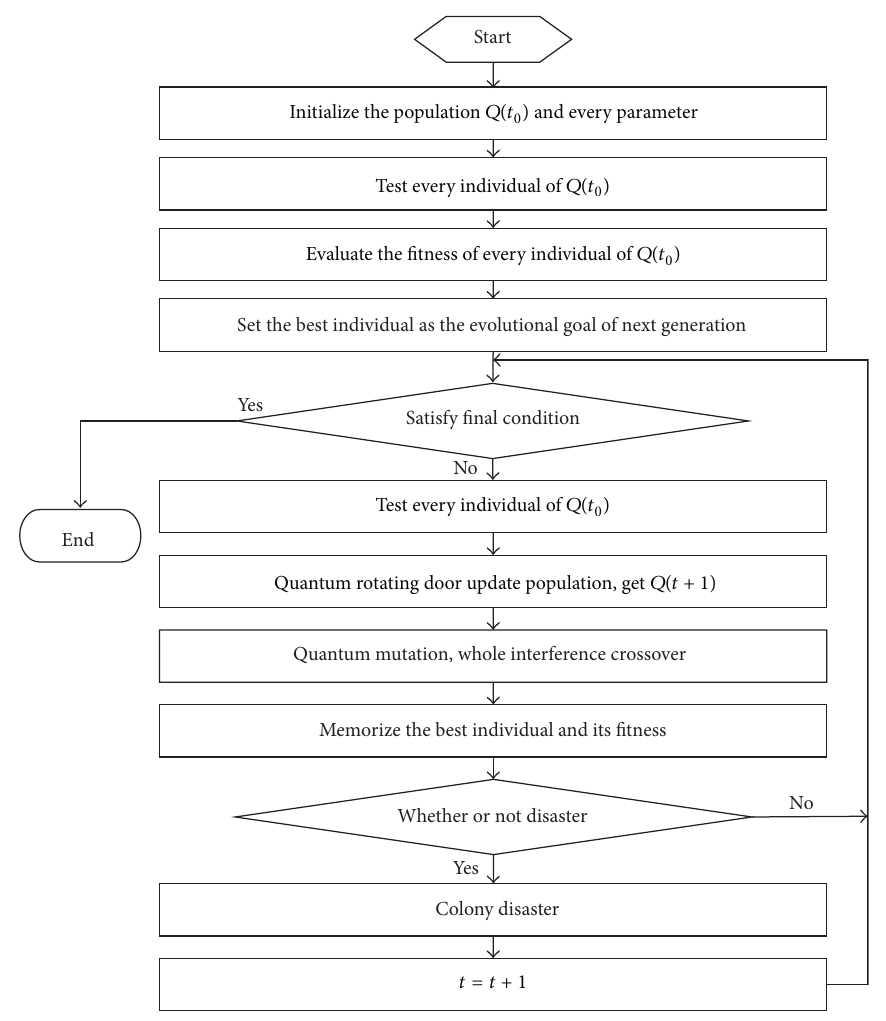
Figure 3: Flowchart of improved quantum genetic algorithm.